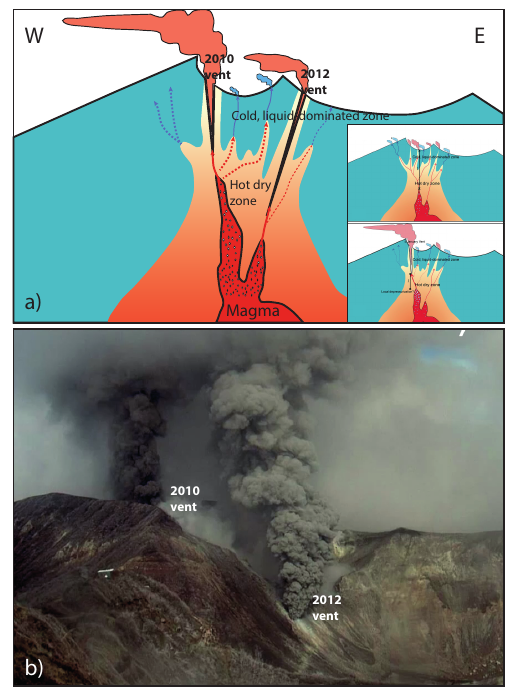
Figure 8. (a) Schematic cross-sectional representation of the sum- mit area of Turrialba at the time of writing. The figure is drawn after the style of Fig. 7 in Campion et al. (2012) (reproduced as inset) showing the progression of the “hot dry zone” since the opening of the 2012 vent. The figure also represents the 2012 vent linked at a slightly deeper level than the 2010 vent as to explain the difference in gas ratios (see text). (b) Photograph from the Turrialba webcam taken on 21 May 2013 showing the most recent ash eruption, in which both vents erupted